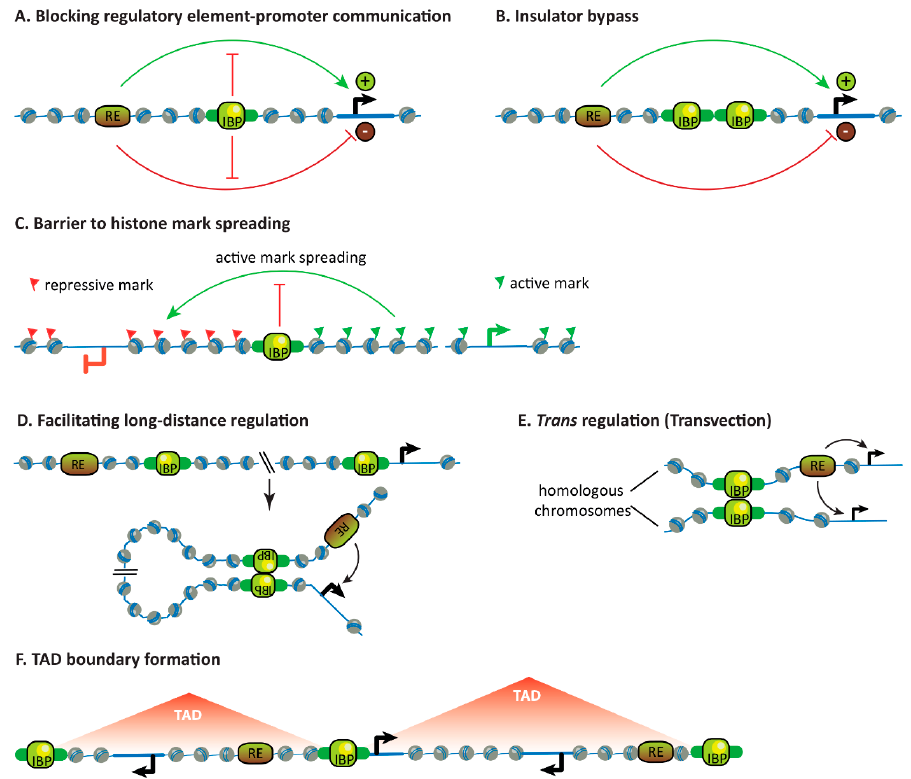
Figure 3. Properties of insulators and their binding proteins. Insulators may block the communication between regulatory elements and promoters ( A ), support bypass when paired ( B ), act as barriers to histone mark spreading ( C ), facilitate long-distance communication between a regulatory element and a promoter in cis ( D ) and in trans ( E ), and form boundaries of Topologically Associated Domains (TADs) ( F ). Some of these properties have so far only been described in flies (B and E) and others only in mammals ( F ).